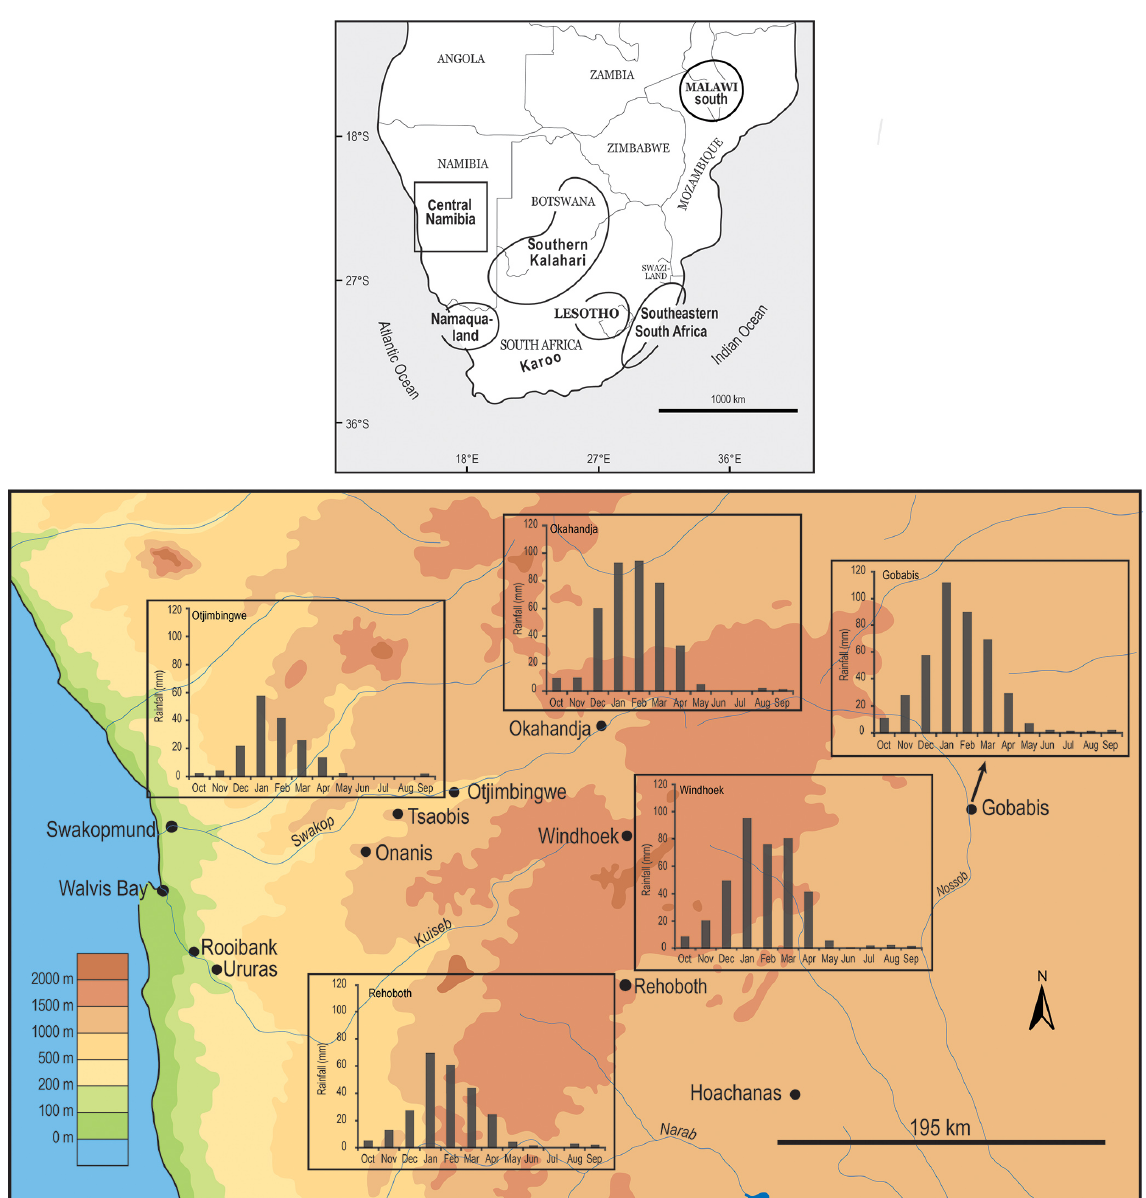
Figure 1. The map of southern Africa indicates the central Namibia study region and other areas for which documentary-based 19th-century climate reconstructions are available (please also see Fig. 4). The topographic map of central Namibia indicates the location of primary mission stations and their mean monthly rainfall during the period